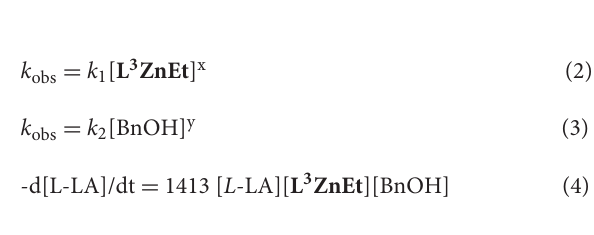
FIGURE 5 | First-order kinetic plots for L -LA polymerizations vs. time in toluene (10mL) at 25 ◦ C with various concentrations of complex [ L 3 ZnEt